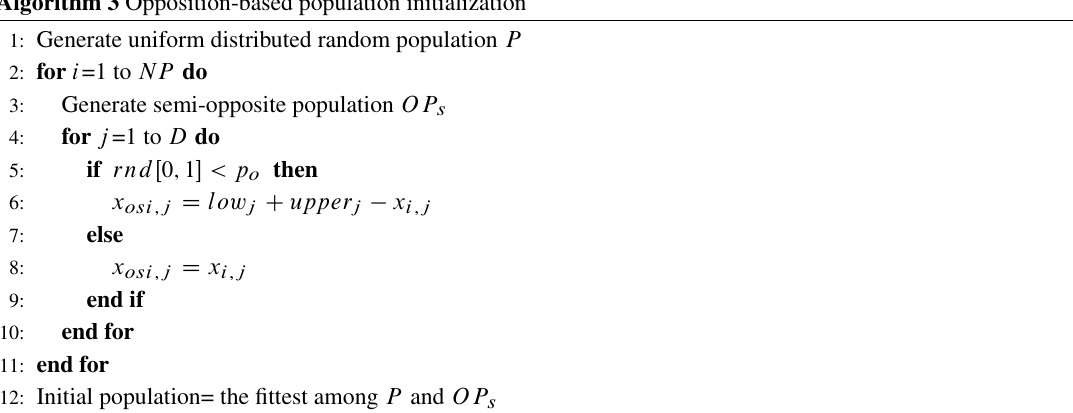
Algorithm 3 Opposition-based population